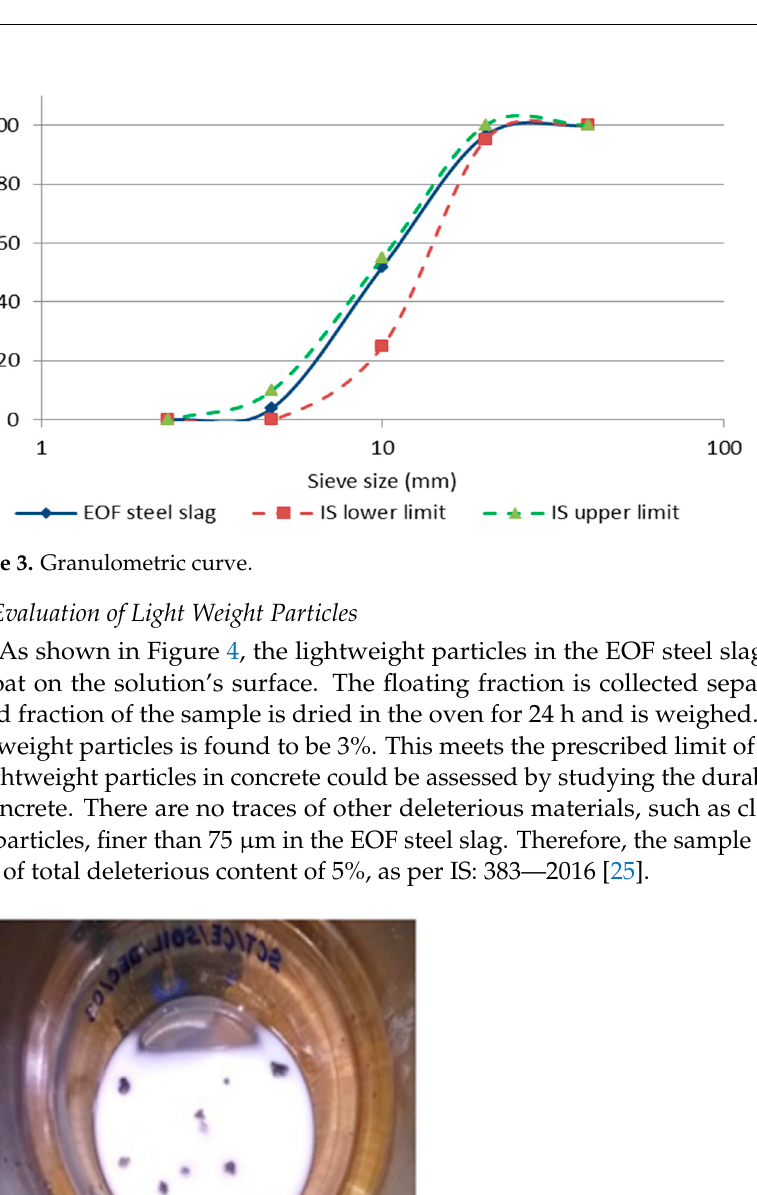
Figure 4. Lightweight particles floating in the zinc chloride solution.